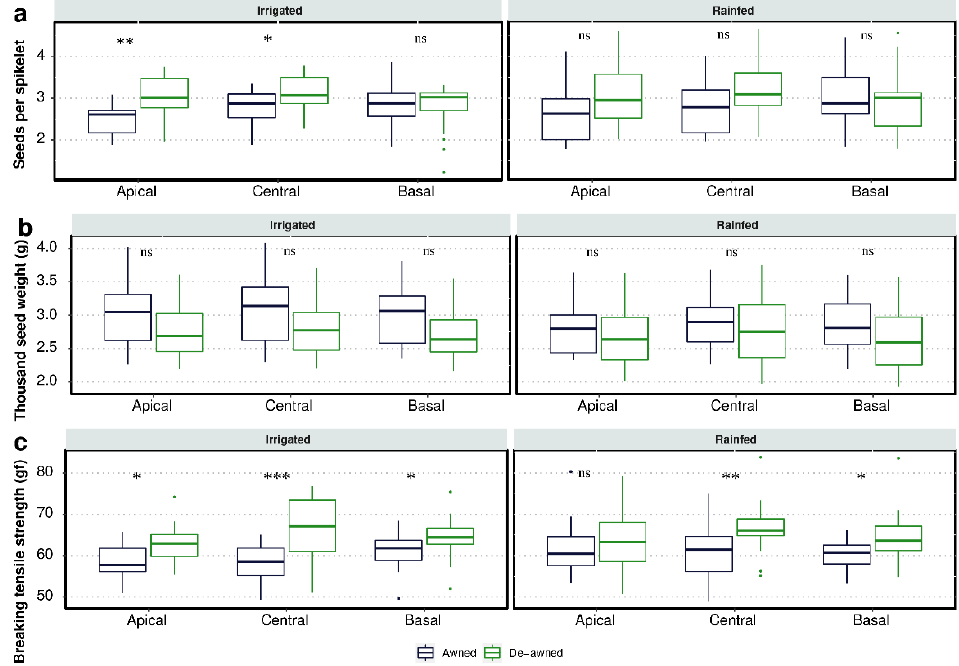
Figure 5. Box plots summarizing seeds per spikelet ( a ), thousand-seed weight ( b ), and breaking tensile strength ( c ) in the apical, central, and basal spikelets of the spikes. ns: not significant, * p < 0.05, ** p < 0.01, *** p < 0.001. Each box plot denotes the average of 10 accessions for corresponding traits. The significances indicate the comprehensive effect of awn excision on different traits of 10 Siberian wildrye accessions.